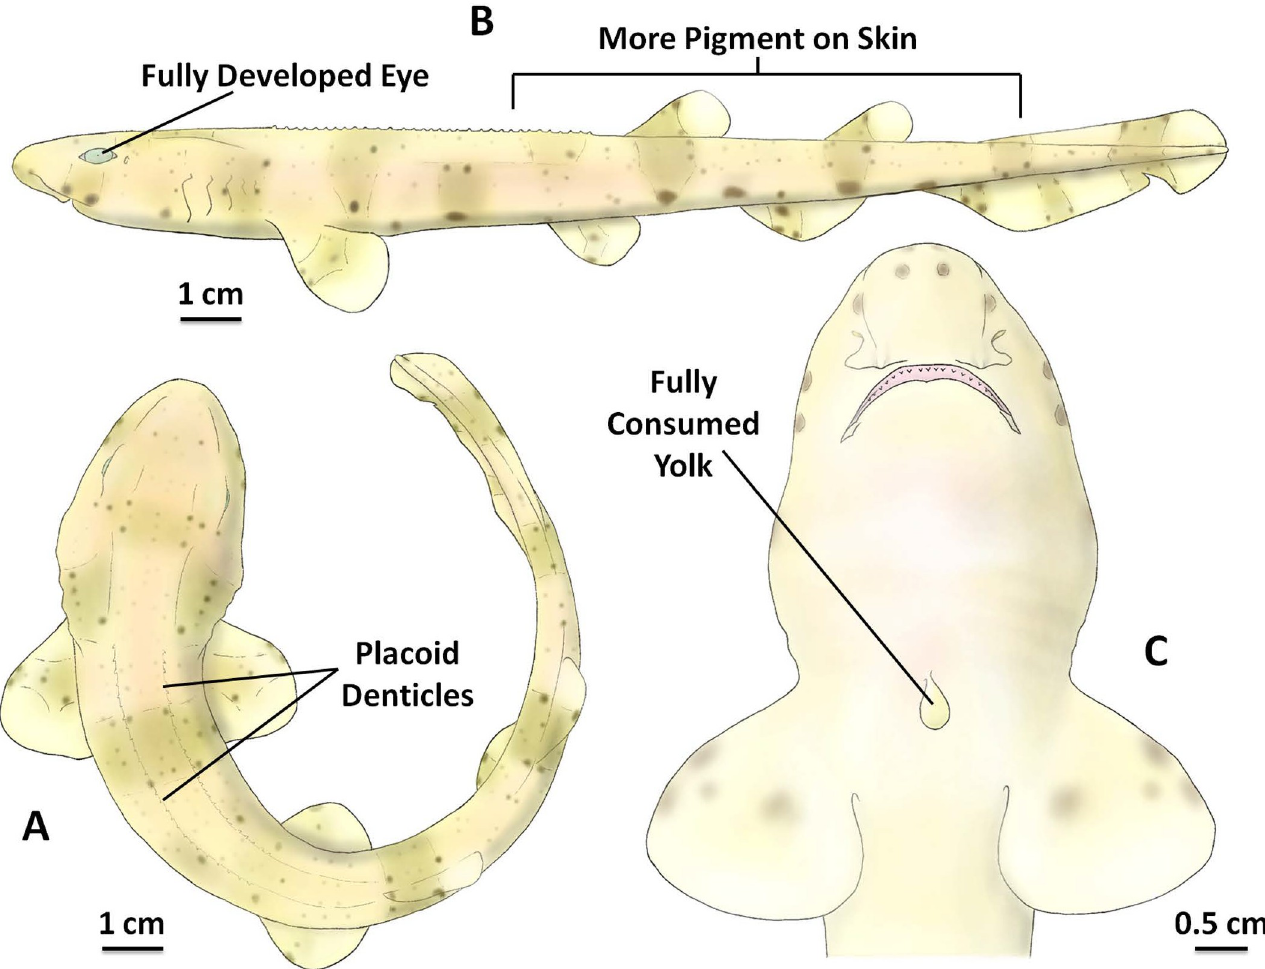
Fig 7. The inside of the S . stellaris egg case at stage 7. A: Position of placoid denticles and banded patterns on the body (dorsal view). B: Fully developed eye and greater pigmentation on skin (lateral view). C: The magnified head and fully consumed yolk (ventral view). The key feature for stage 7 embryo was a fully consumed external yolk. See S7 File for original photographs of Fig 7